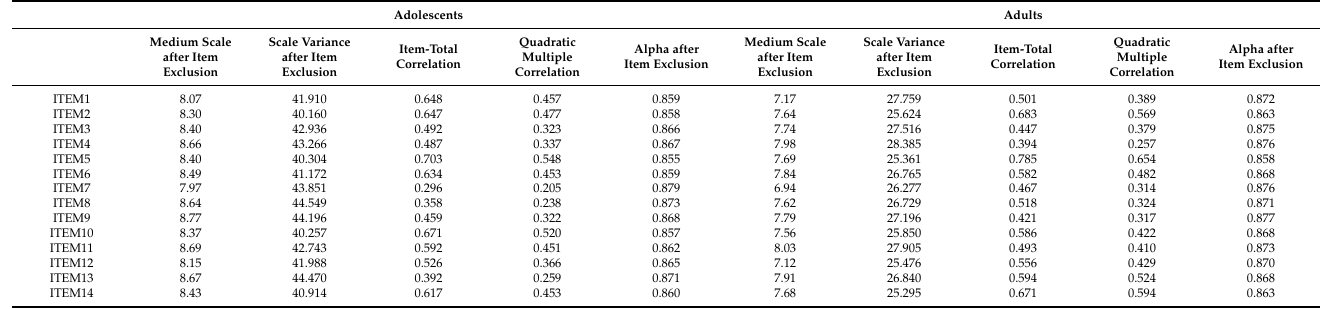
Table 2. Alpha deleted analysis of the BSIS scale in the adolescent and adult population.